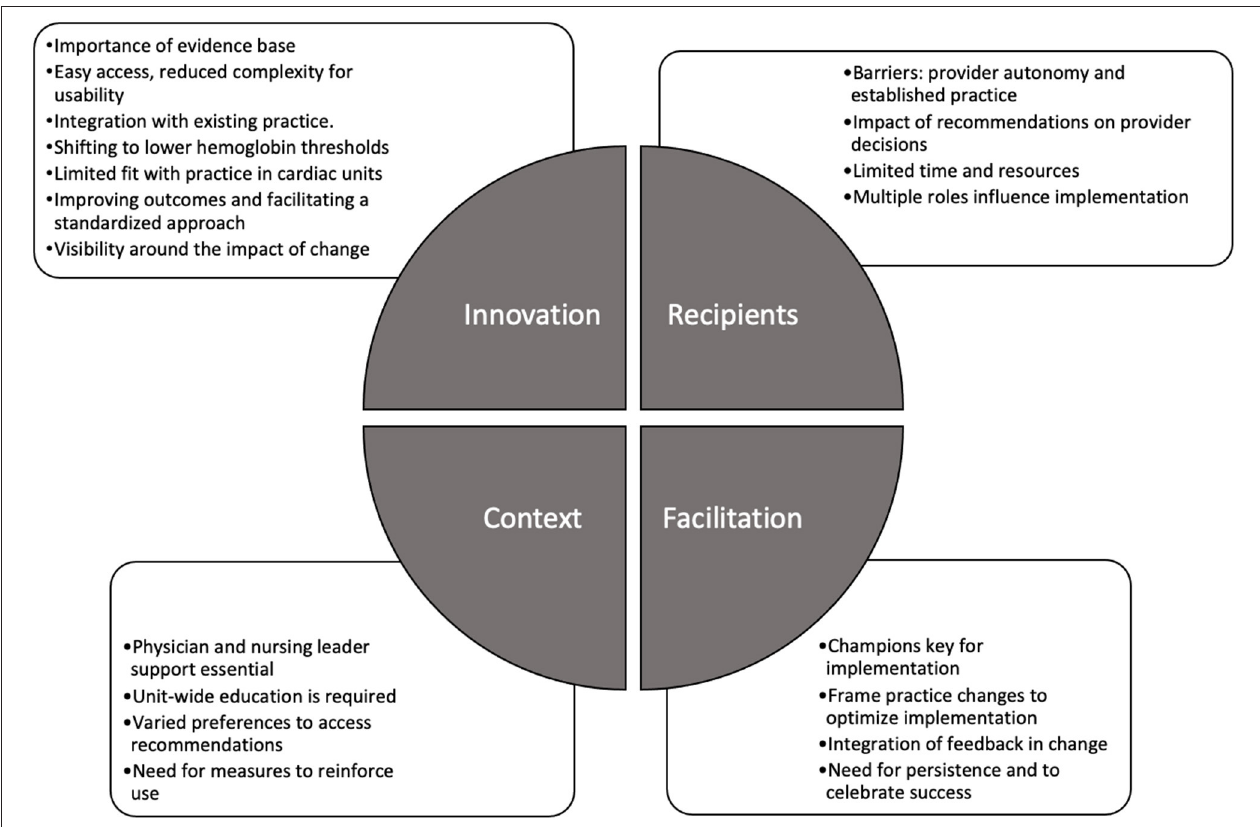
FIGURE 1 | Themes identified within each of the iPARIHS